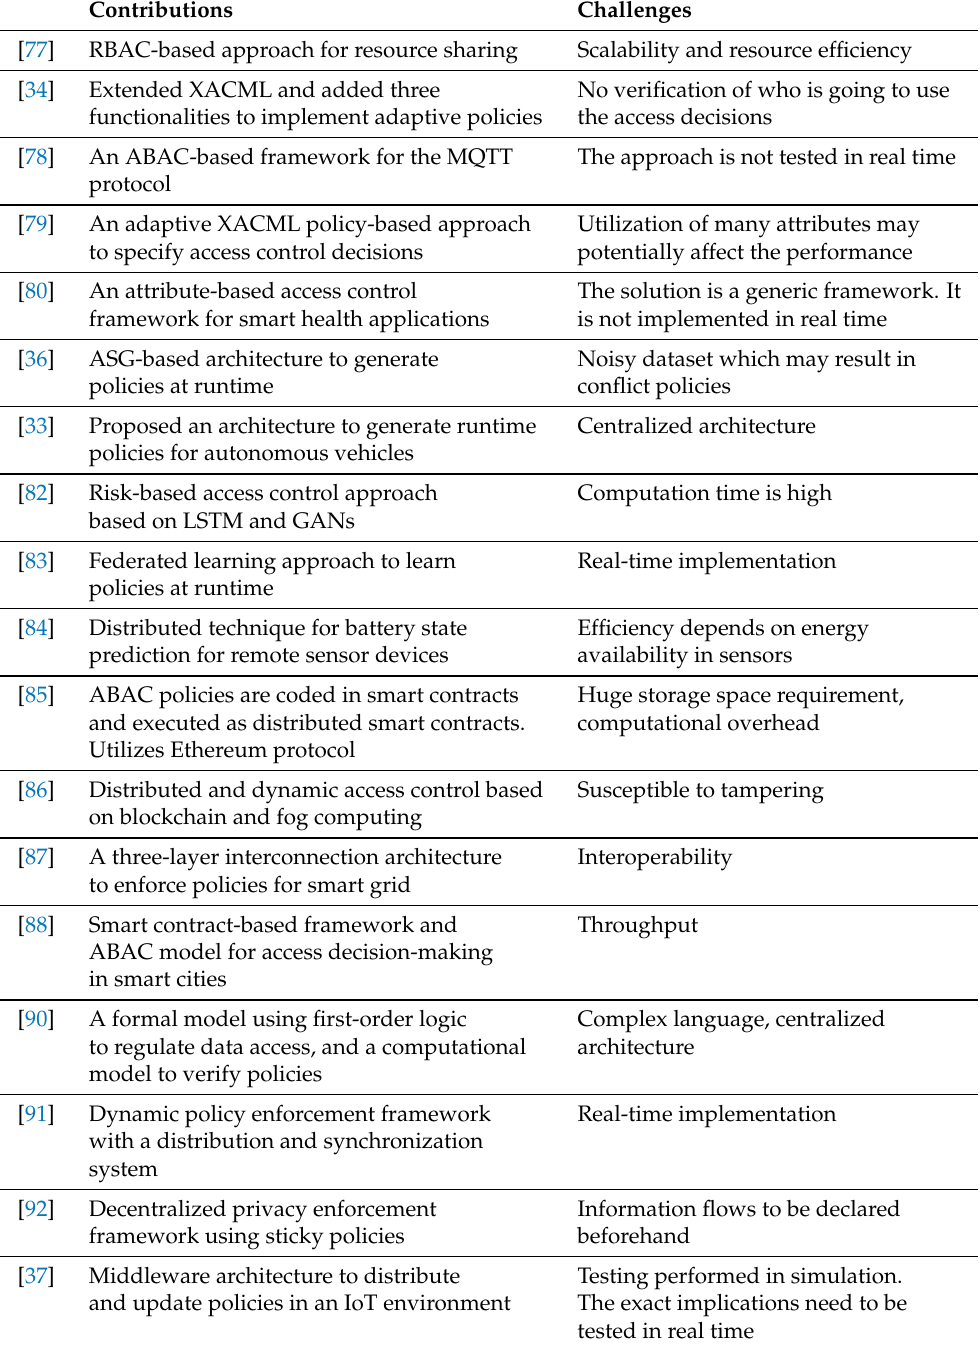
Table 2. Analysis of Dynamic Policies’ Specification